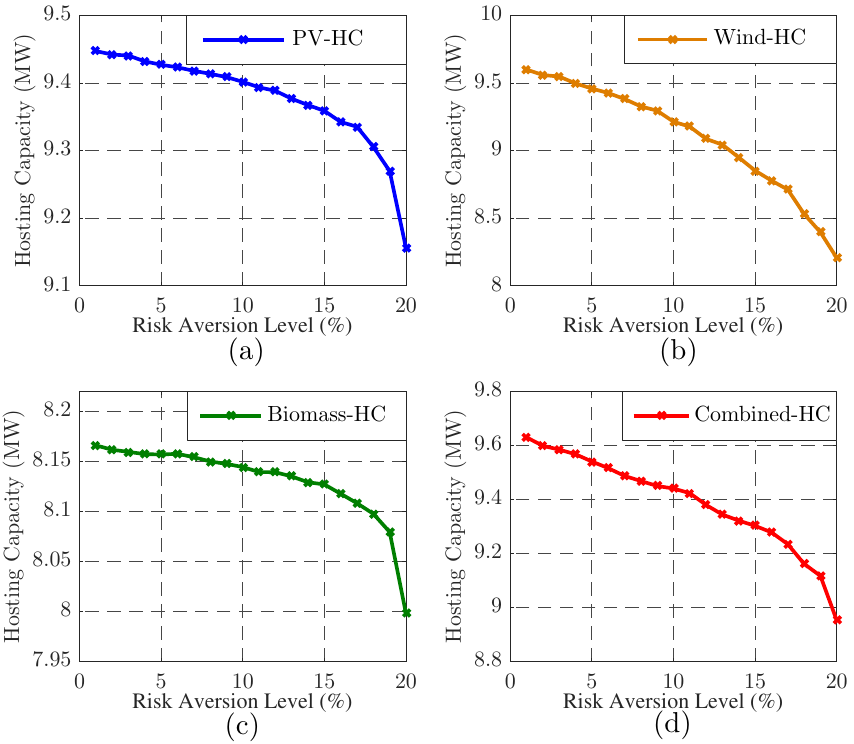
Figure 5. The value of data for the HC obtained via the proposed DRO-HC method with τ = 10% for different technologies including: ( a ) PV; ( b ) wind; ( c ) biomass; and ( d ) combination of PV, wind and